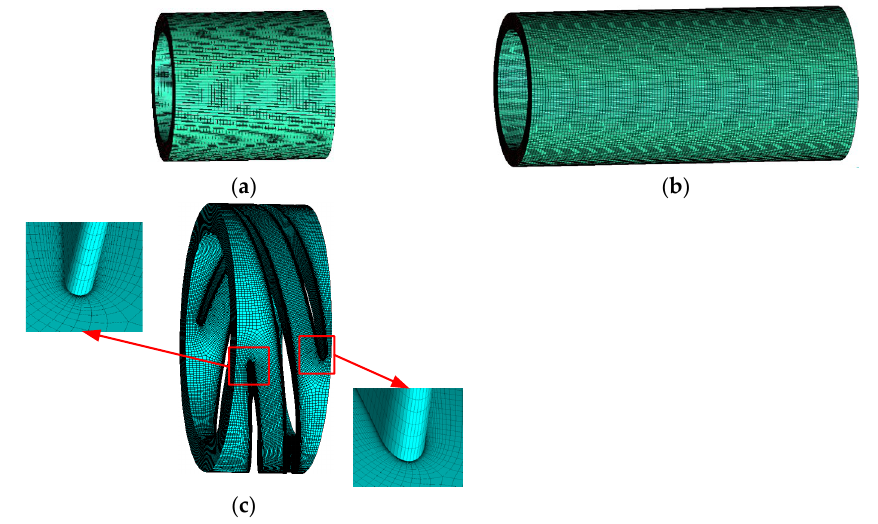
Figure 2. Computational mesh ( a ) inlet pipe; ( b ) outlet pipe; and ( c ) impeller. Table 1. Mesh quality.